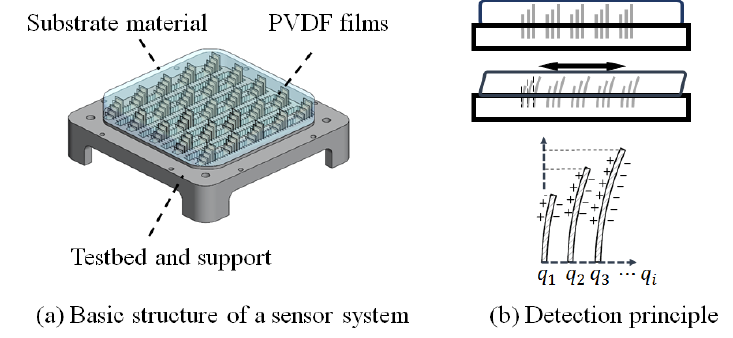
Figure 1. Shear strain measuring device.